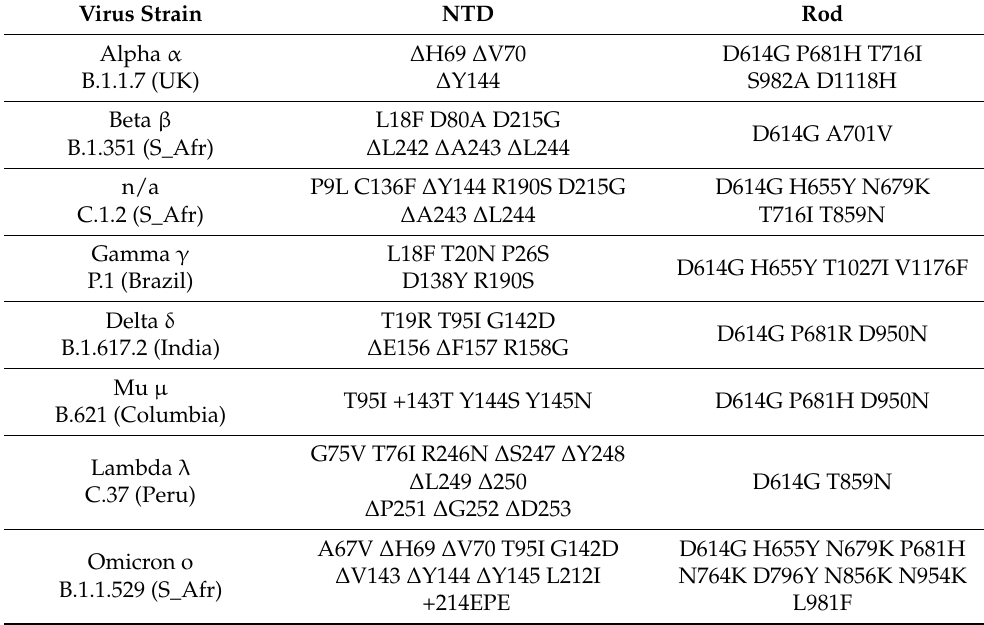
Table 1. Mutations in SARS-CoV-2